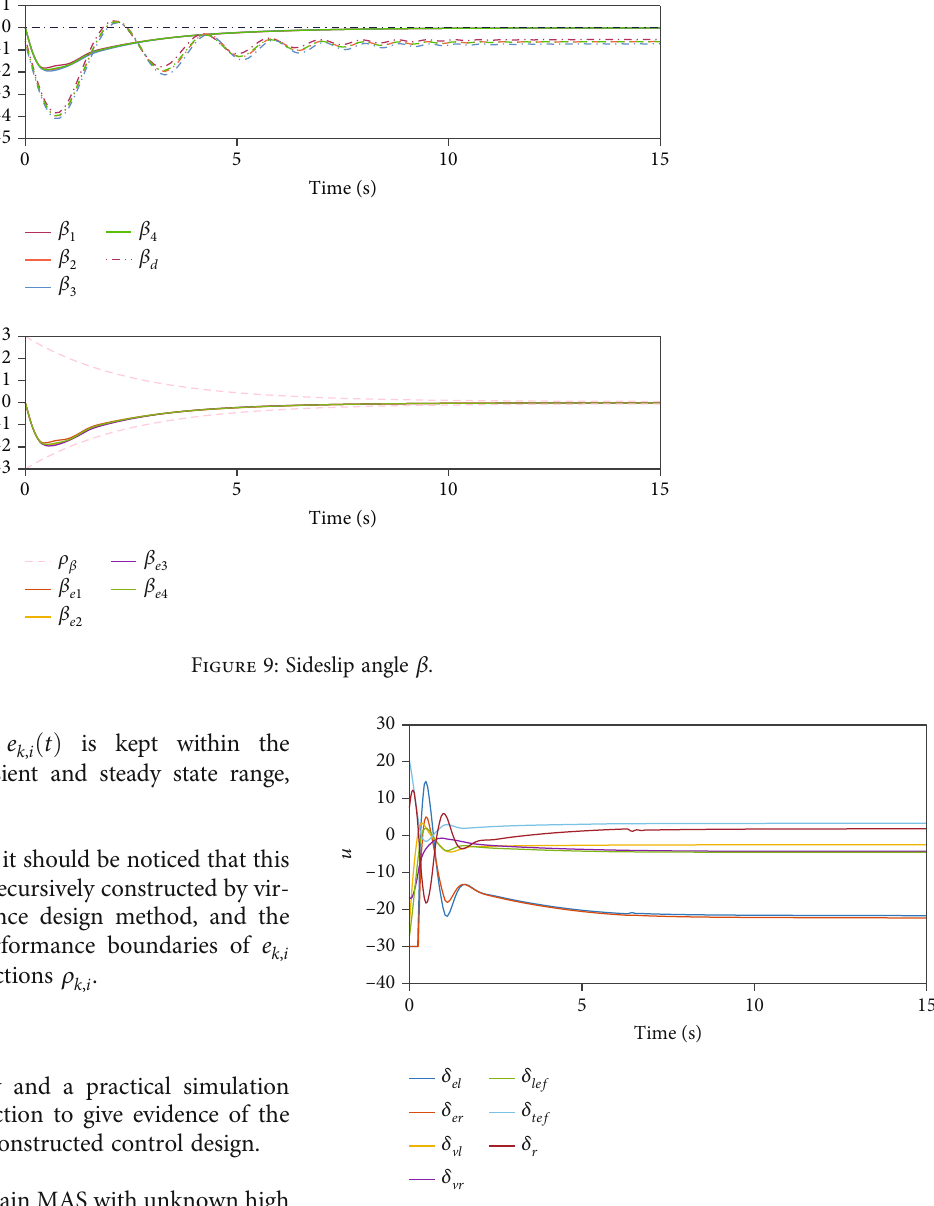
Figure 10: The responses of actuator of fi ghter